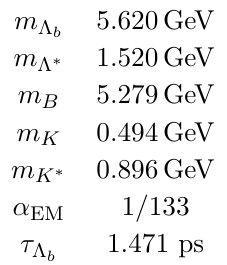
Table 3 . Numerical inputs of our parametrisation. All inputs are taken from the PDG [20], apart from the Λ b lifetime